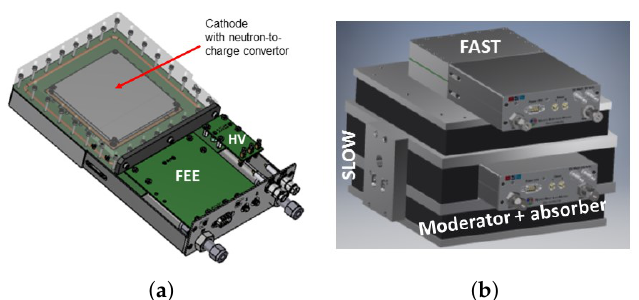
Figure 23. ( a ) Design of the neutron Beam Loss Monitor detector. A cathode with a neutron-to-charge converter is the cathode. Outside the gas volume there is a HV card that powers the Micromegas and the cathode and a FEE card with the current preamplifiers. ( b ) View of both modules together, where the second one is surrounded by a moderator and neutron absorber, as explained in the